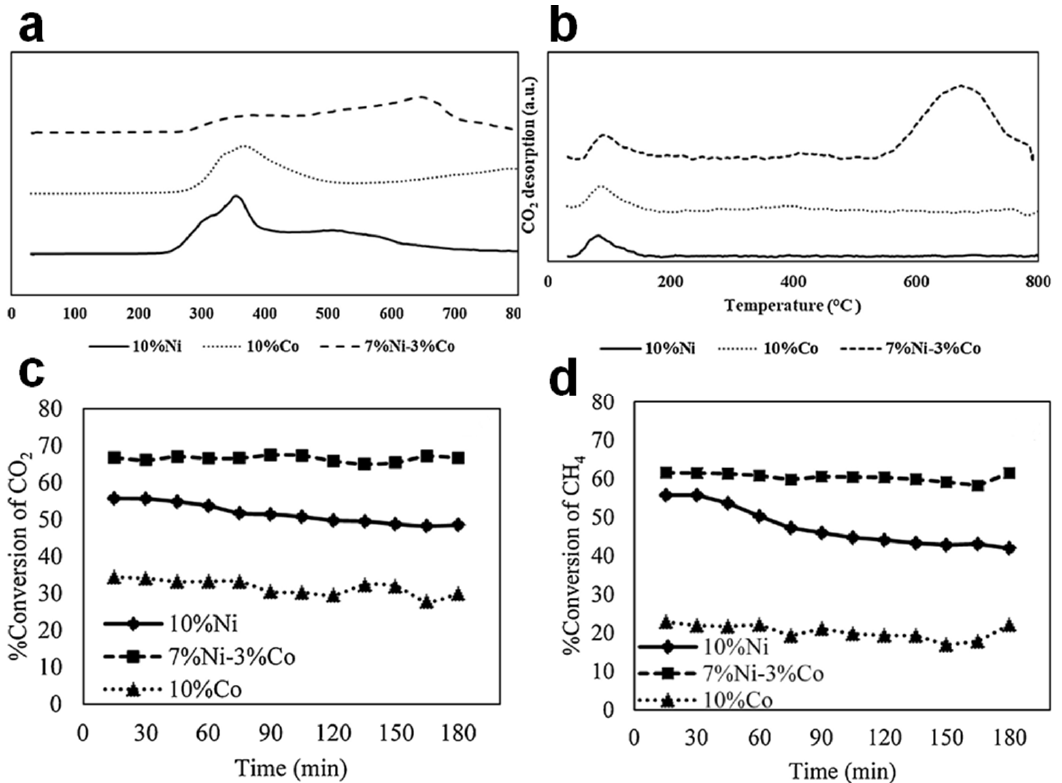
Figure 4. ( a ) The TPR profiles of the nickel–cobalt monometallic and bi-metallic catalysts over γ -Al 2 O 3 -HY zeolite. ( b ) CO 2 - TPD profiles of the nickel–cobalt monometallic and bi-metallic catalysts over γ -Al 2 O 3 -HY zeolite. Catalytic performance of ( c ) CO 2 conversions and ( d ) CH 4 conversions. Reproduced with permission from [63]. Copyright 2020,